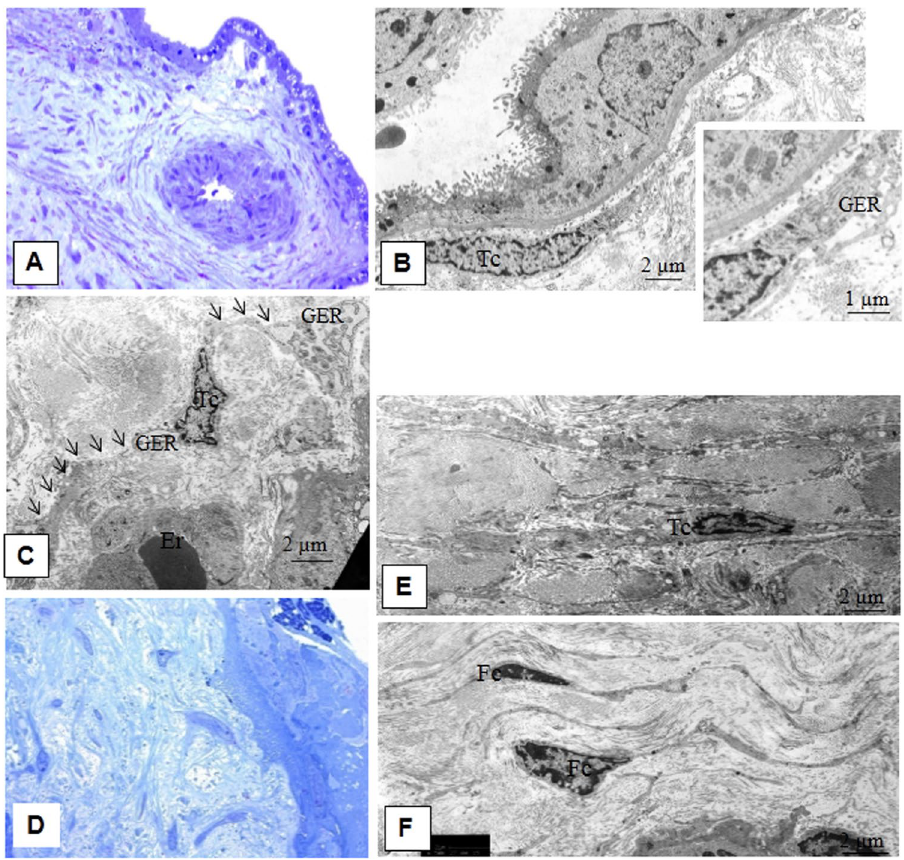
Figure 8. Morphological features of the stem villi stroma in preeclampsia. ( A ) Stem villi. Semithin section, × 400 (Methylene blue staining). ( B ) Spindle-shaped telocyte-like cells (Tc) (average diameter 1.92 ± 0.9 μ m) are located under the syncytiotrophoblast basement membrane. Its processes (diameter a mean 0.22 ± 0.2 μ m) form a network. In the perinuclear zone, these telocyte-like cells contain developed granular endoplasmic reticulum, indicating fibroblast differentiation (insert). Electron microphotographs, × 6500 and × 11000. ( C ) A stellate-shaped telocyte-like cell (Tc) (average diameter 2.89 ± 1.1 μ m) with several processes (average diameter 0.38 ± 0.3 μ m) is observed in the fibrous stroma of stem villi. Well-developed granular endoplasmic reticulum (GER) are revealed in the perinuclear zone and among process dilatations. Processes of telocyte-like cell are indicated with arrows. Electron microphotograph, × 6500. ( D ) Stem villus with advanced stromal fibrosis. Semithin section, × 400 (Methylene blue staining). ( E ) Stellate-shaped telocyte-like cells (Tc) with developed granular reticulum in the roughly fibrotic stroma. Electron microphotograph, × 6500. ( F ) Fibrocytes (Fc) (average diameter 2,28 ± 0.6 μ m) with processes (average diameter 0.40 ± 0.3 μ m) in a roughly fibrotic stroma. Fibrocyte nuclei with large heterochromatin lumps. There are single glycogen granules in the cytoplasm. Electron microphotograph, ×